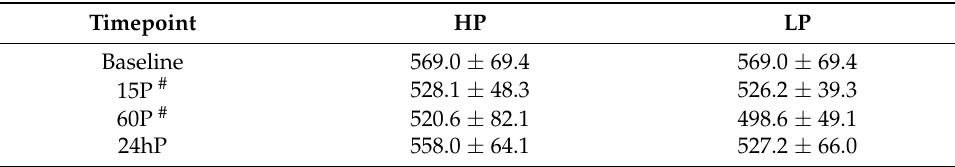
Table 1. Data of the maximum isometric force of the elbow flexors measured at the different timepoints [baseline, 30 min (30P), 60 min (60P) and 24 h (24hP)] in both HP (high pressure) and LP (low pressure) trial. # indicates a significant difference from baseline.